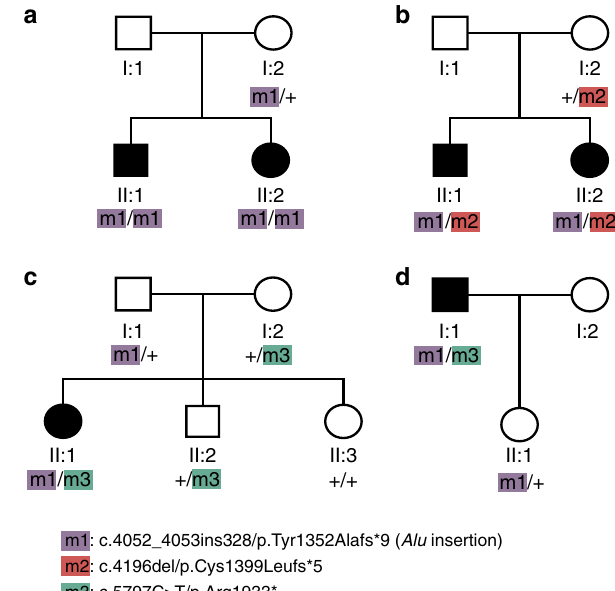
Fig. 1 Segregation analysis of the RP1 mutations found in this